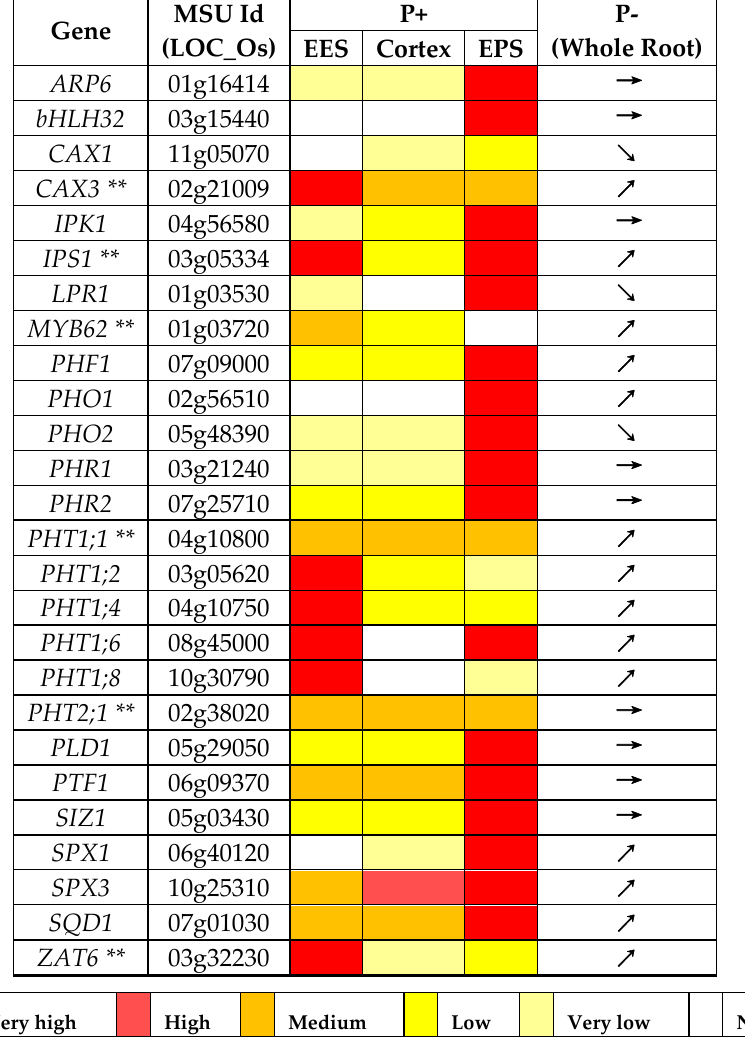
Table 1. Expression of PSR genes in rice root under phosphate sufficient and deficient conditions.